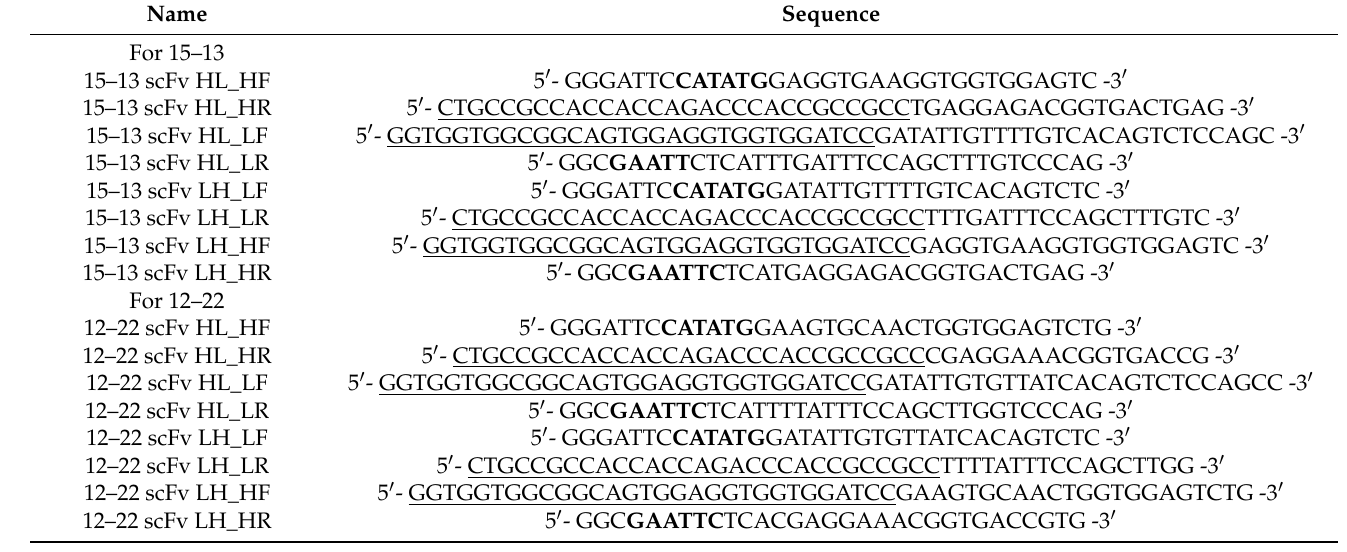
Table 1. Information on primers used for scFv construction. Bold text indicates restriction sites, and underlines indicate the GGGGS repeat